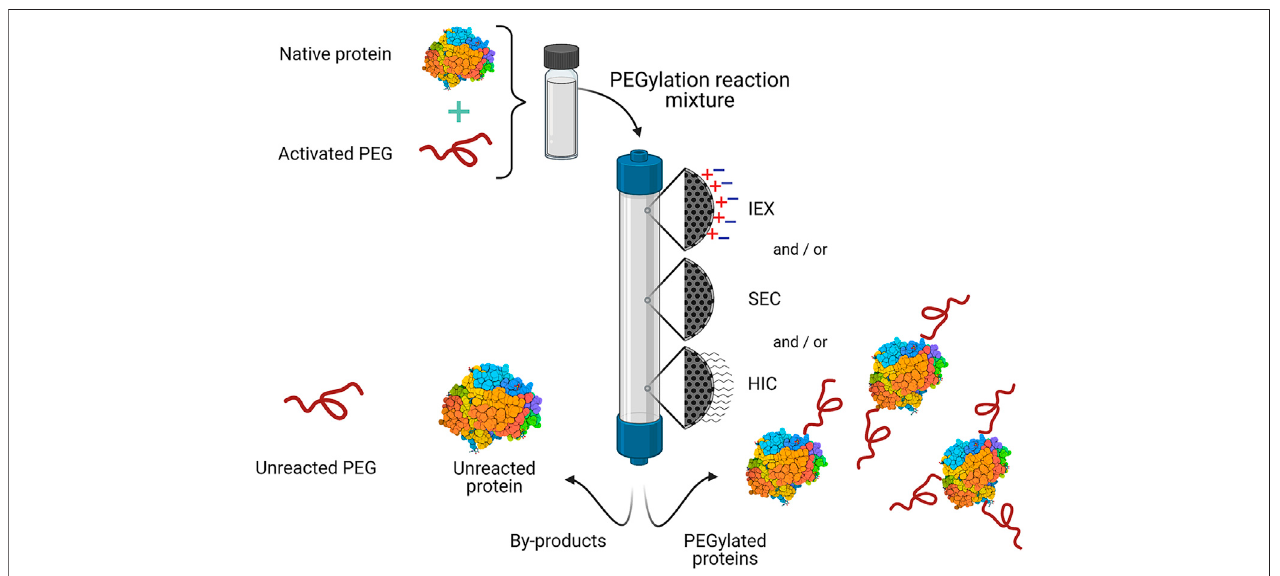
FIGURE2| Generalschemeforthepuri fi cationofcommercialPEGylatedproteinsbychromatography.Oneormorechromatographicoperationalmodesareused to separate the desired PEGylated protein(s) from the PEGylation reaction mixture. IEX, ion exchange chromatography; HIC, hydrophobic interaction chromatography; SEC, size exclusion